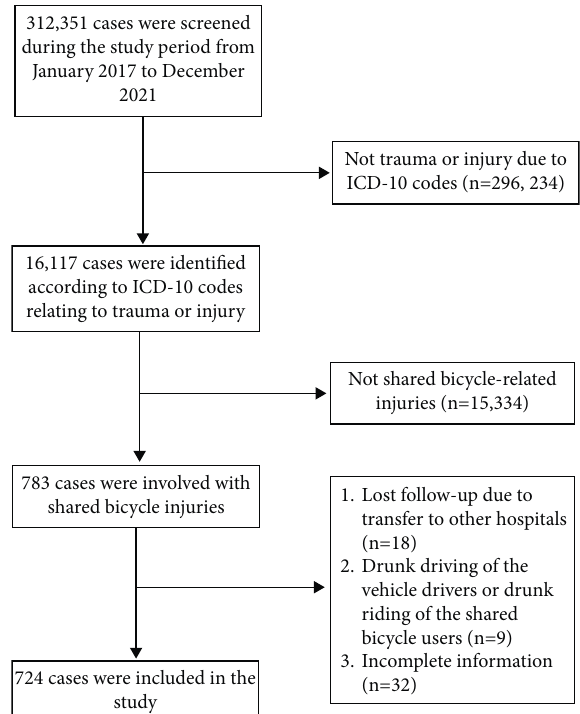
Figure 1: Flowchart of the